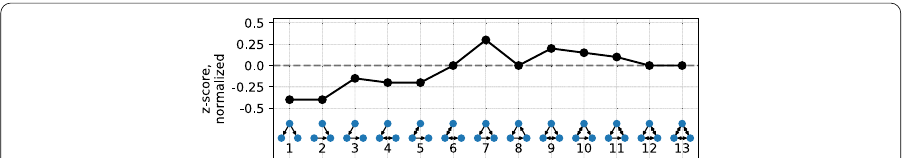
Fig. 7 The target network motif pattern typical to the robust biological systems, reproduced from Milo et al. (2004). X axis represents different subgraphs, Y axis shows normalized z‑score of the corresponding